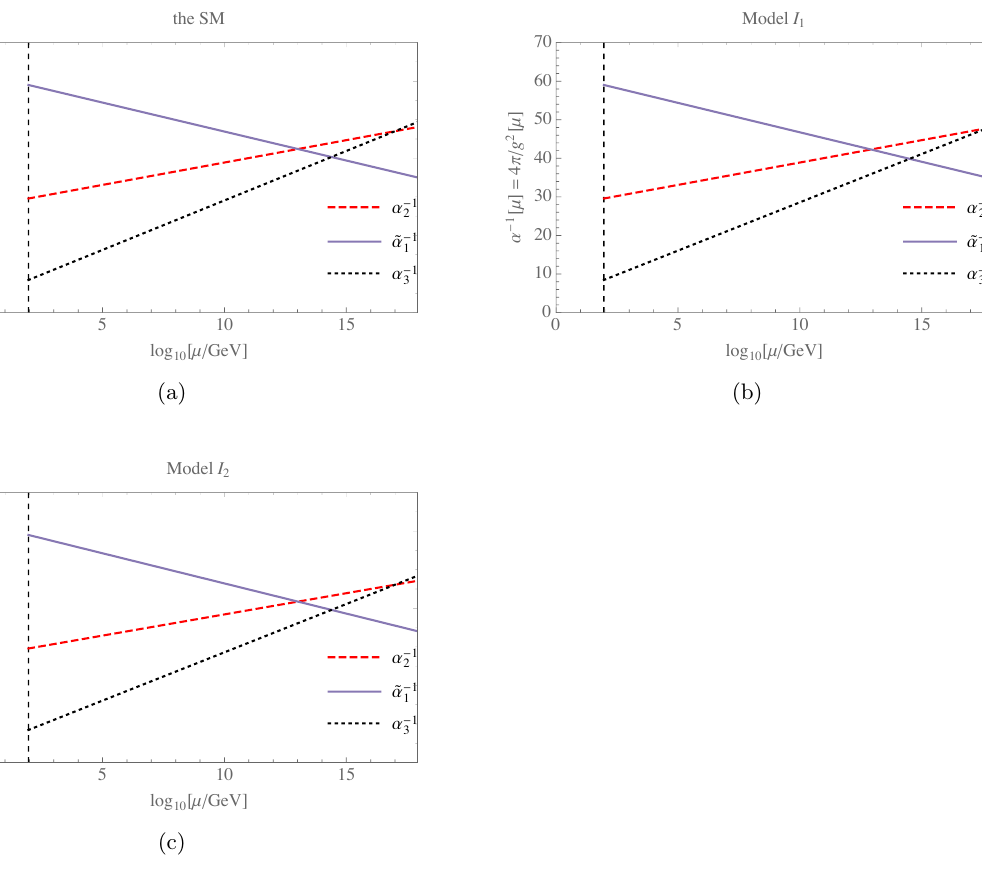
Figure 4 . Running of the gauge couplings for the SM, Model I 1 , and Model I 2 . The vertical dotted line correspond to the electroweak scale M Z . For (cid:11) (cid:0) 1 Including the leptoquark with or without a second Higgs doublet does not make a signi(cid:12)cant modi(cid:12)cation to the SM running in favor of uni(cid:12)cation. Therefore in the NCG framework, one